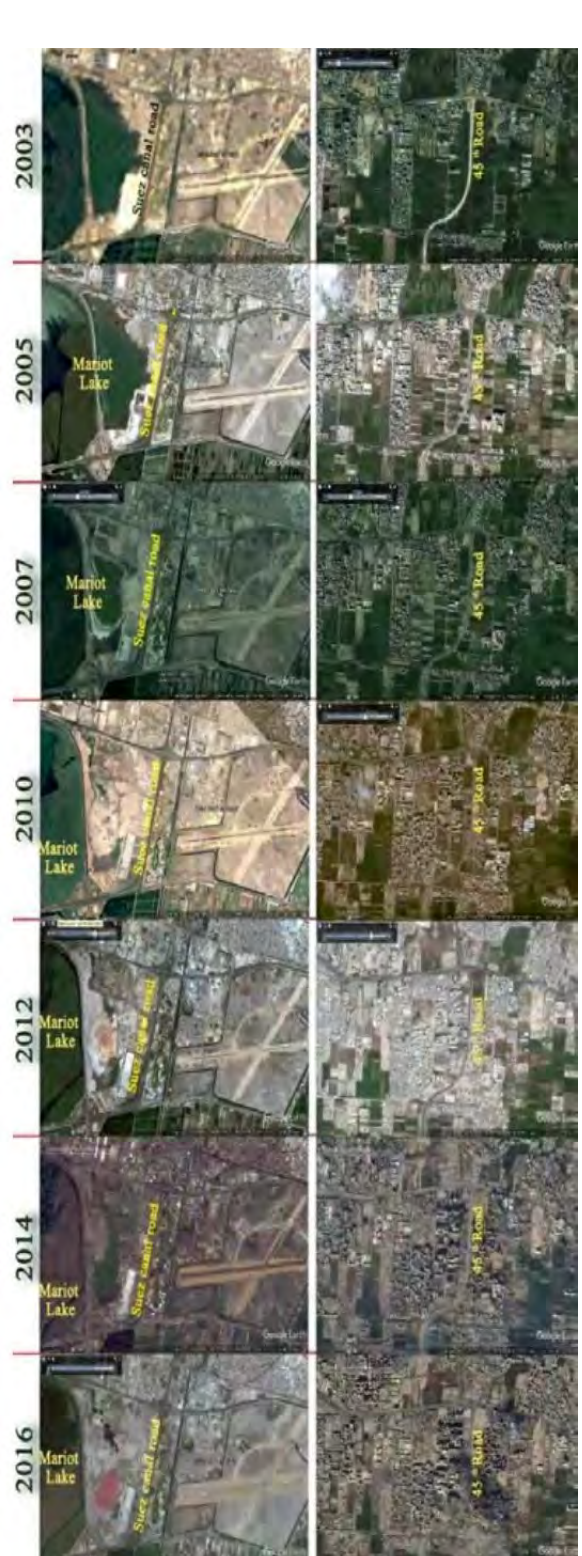
Figure 2. The urbanization process along the Alexandria City two entrances (2003-2016), the Suez Canal Road, and the 45th Road (Google Earth, 2017).